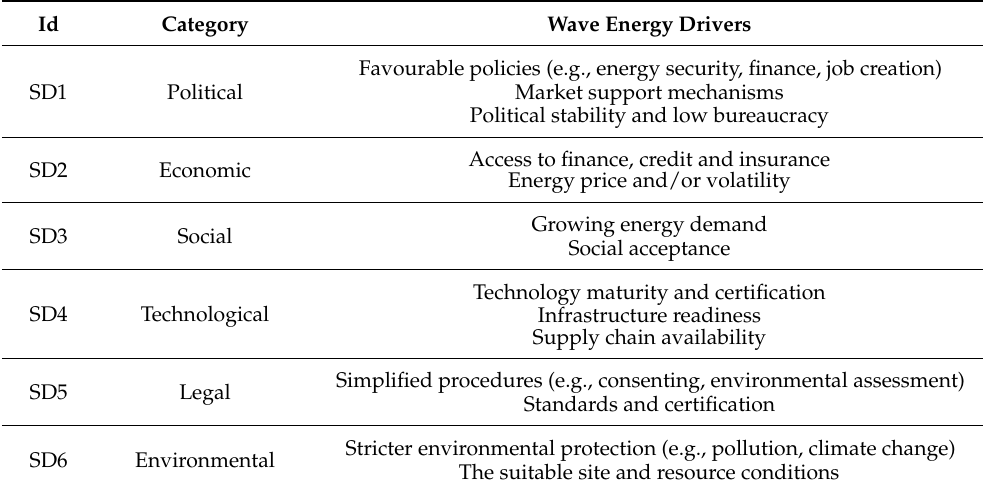
Table 4. System Drivers for wave energy